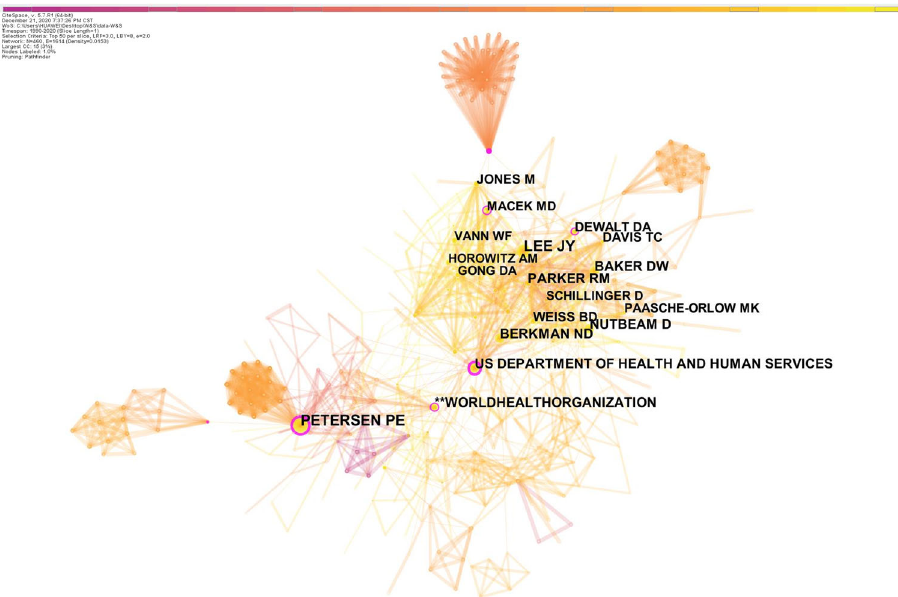
Fig. 4 The distribution of cited authors. The network map of co-cited authors offered to oral health literacy research.